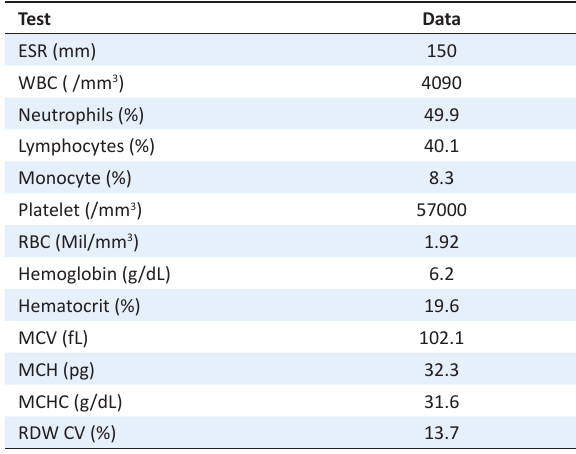
Table 1 . Complete Blood Count of the patient with multiple myeloma and acute renal failure